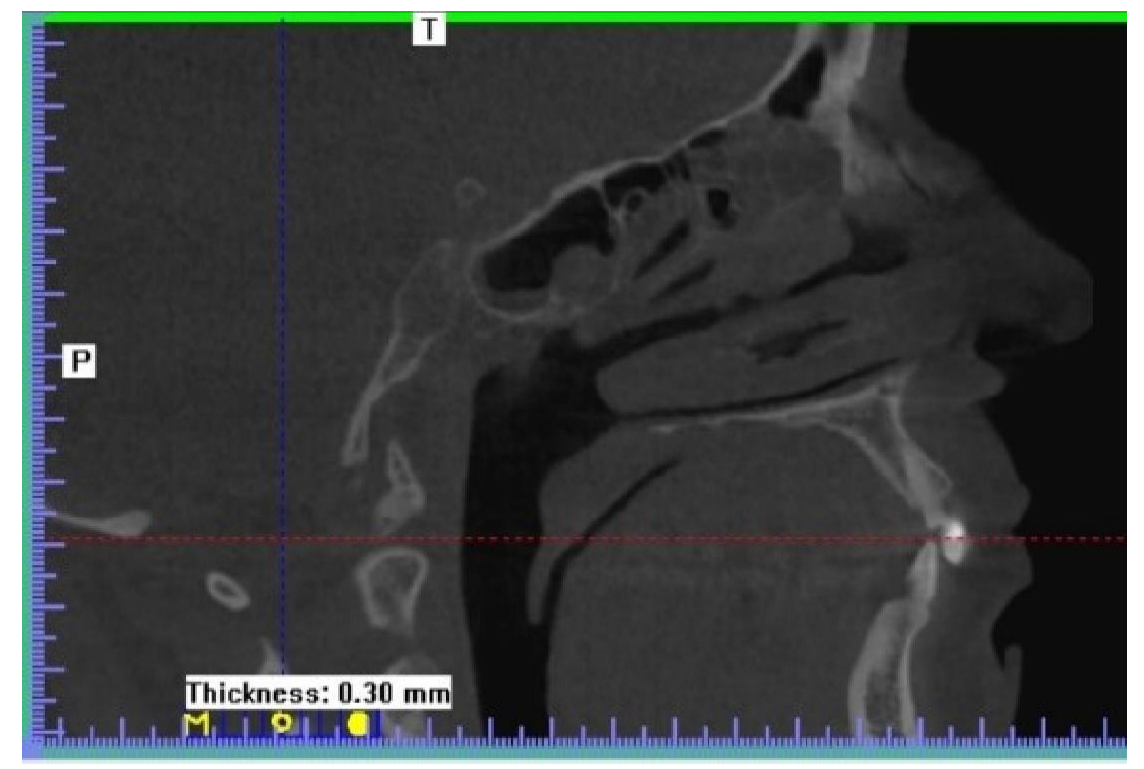
Figure 2. Mucosal thickening in ethmoid cells and at the bottom of the sphenoid sinus—CBCT scan—sagittal view.